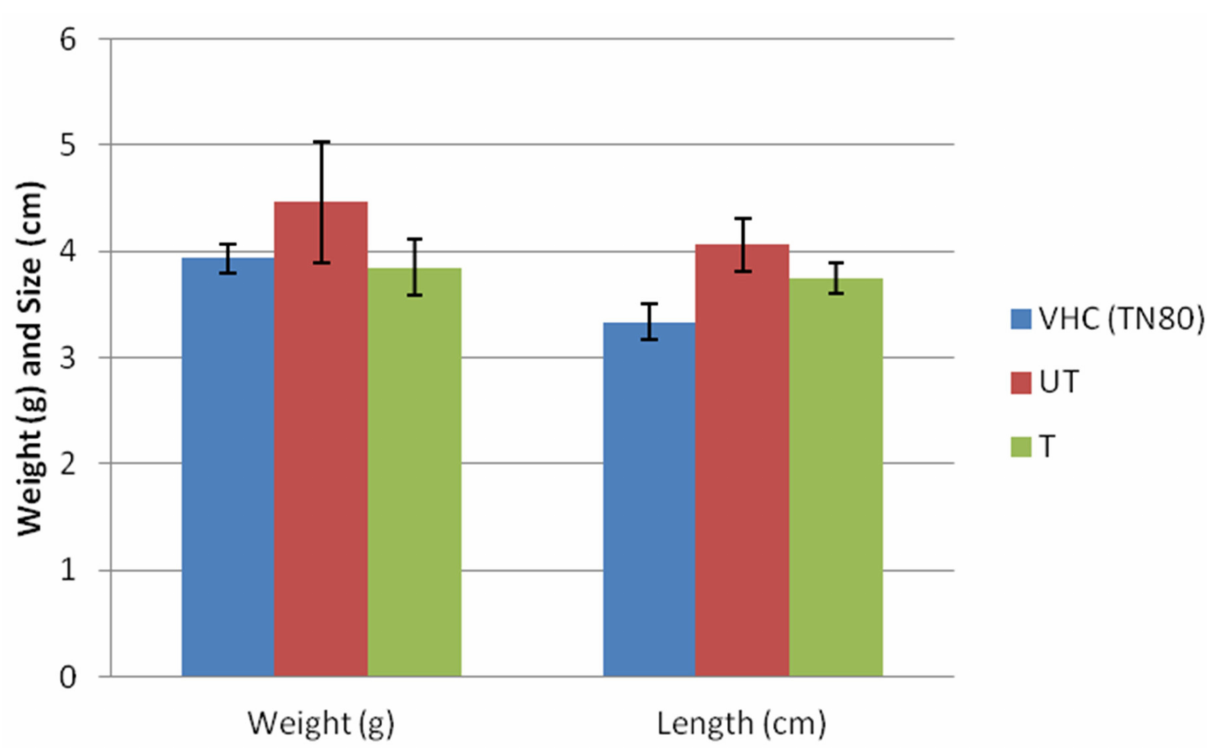
Figure 2. Effects of BPA on weight and length of fetus from vehicle (VHC TN80), BPA-untreated (UT), and BPA-treated (T)